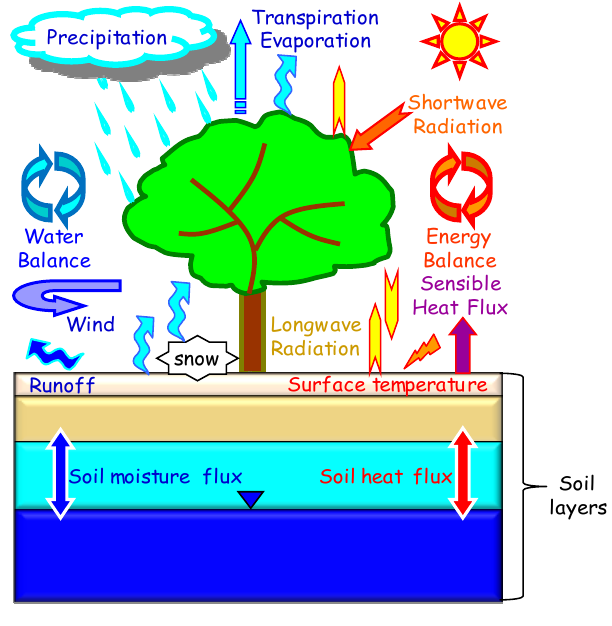
Figure 1. Conceptual schematic for hydrological and biogeophysical processes simulated in the Common Land Model